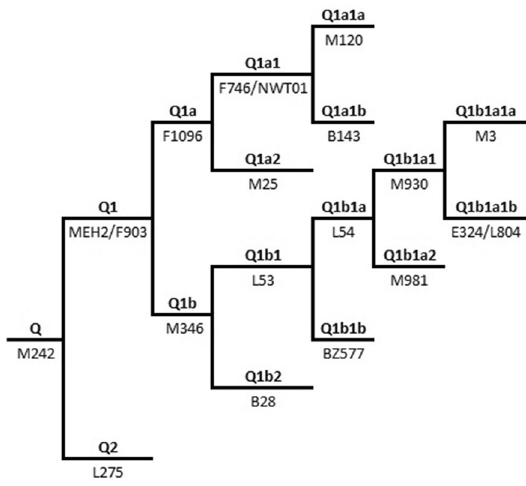
Figure 2. Phylogenetic relationship of Y-SNP